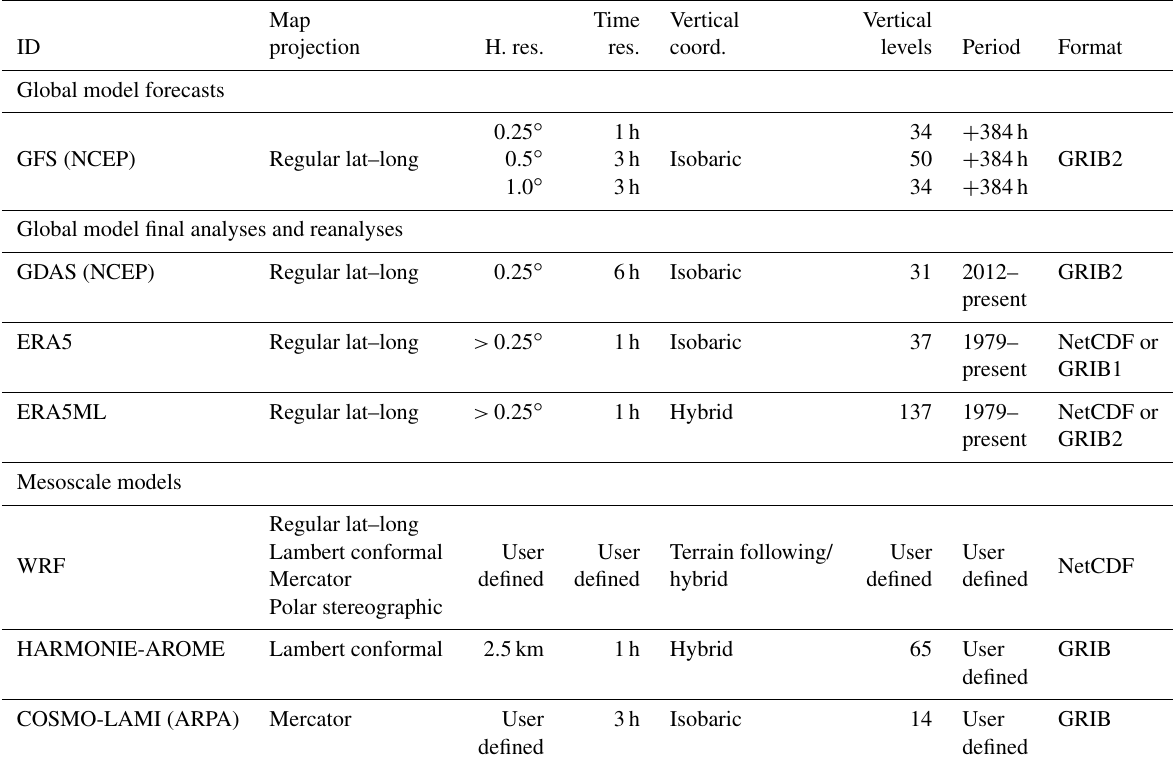
Table 12. Summary of the meteorological drivers available in FALL3D-8.0. Map Time Vertical Vertical ID projection H. res. res. coord. levels Period